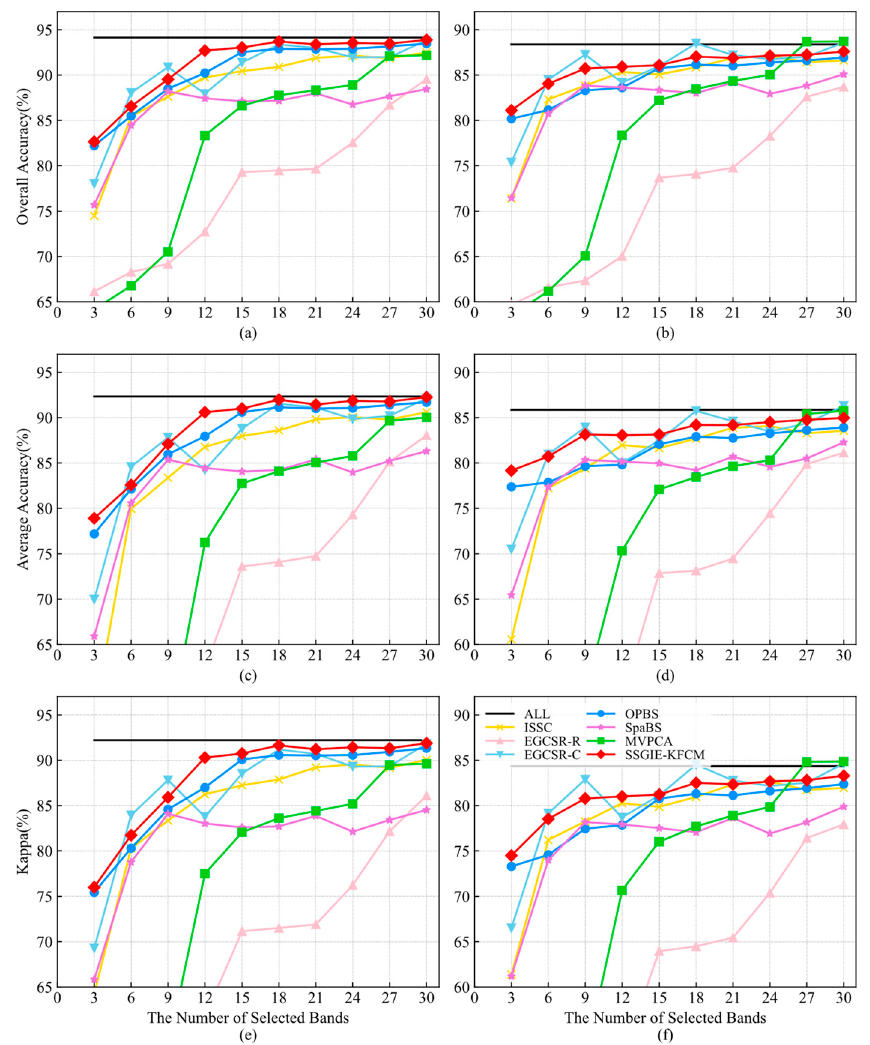
Figure 7. Classification accuracy of different band selection methods on the Pavia University dataset with different band subset sizes. ( a , c , e ) are SVM classifiers; ( b , d , f ) are KNN classifiers.